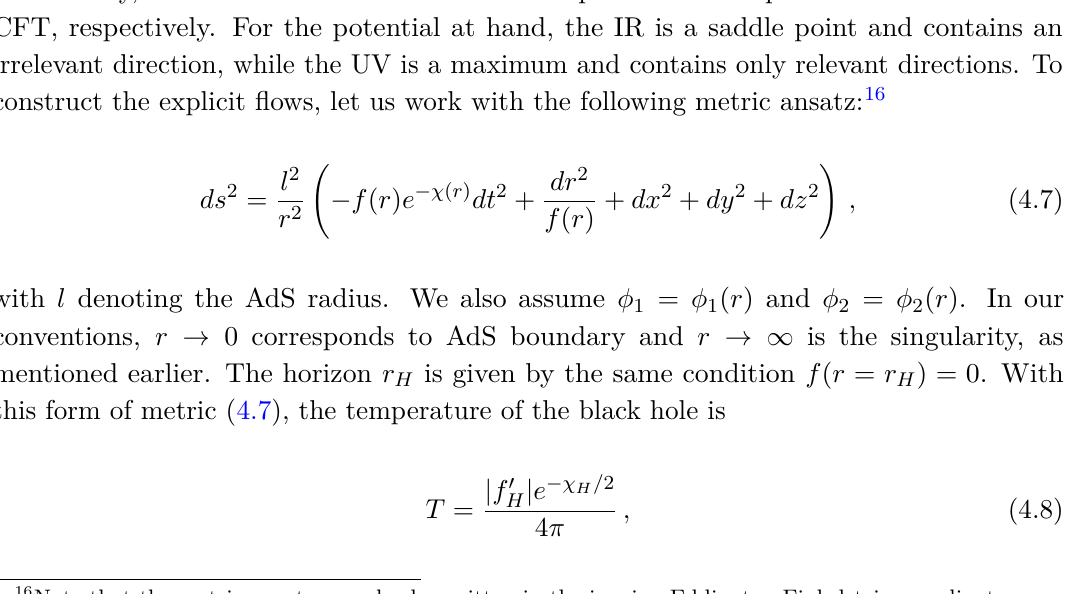
= − 3 g 2 and ( φ ,φ ) = ( ± 1 log3 , 1 √ log2) max 1 3 4 2 6 and V at the max sad